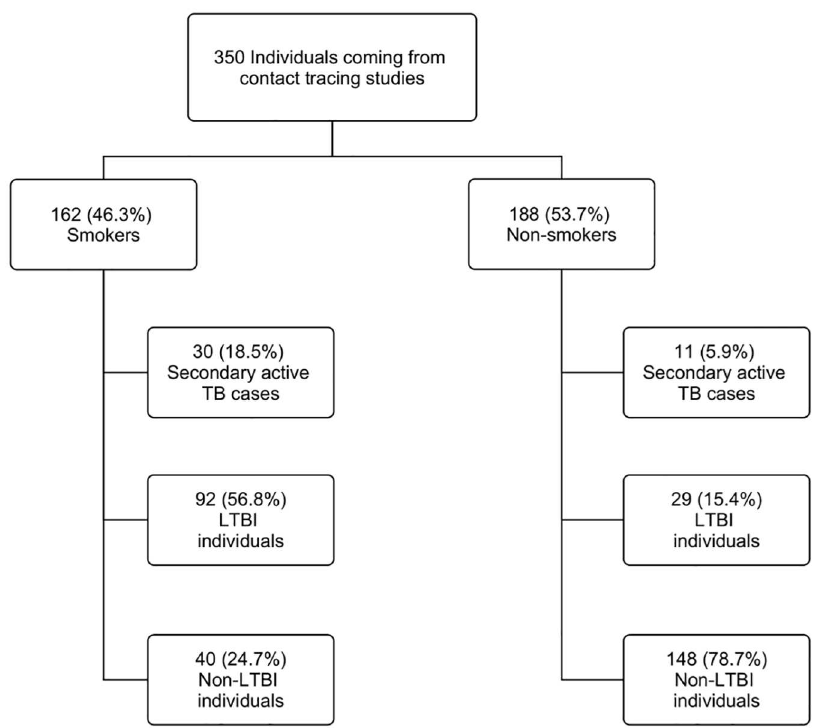
Fig 1. Final diagnosis of all the individuals recruited during contact tracing studies. LTBI, non-LTBI and secondary active TB cases were stratified regardingtheir smoking or non-smoking condition.LTBI was definedas having positive IGRAs (T-SPOT.TB and/or QFN-G-IT) and a chest radiography without alterations. Active TB cases presented microbiologic confirmation by culture, a compatibleradiography with the disease and good clinicalresponseto anti-TB